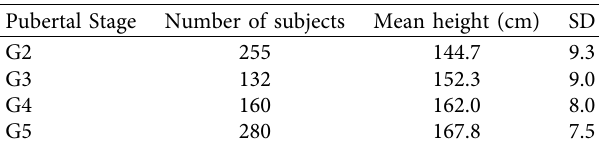
Table 3: Mean height at different stages of pubertal development in our